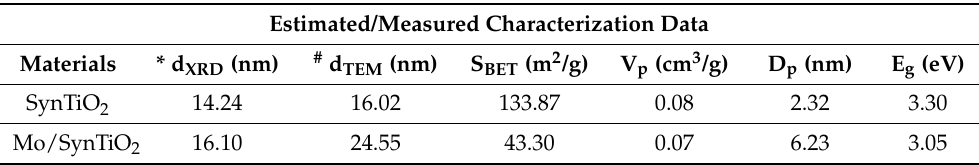
Table 1. Material properties of unmodified SynTiO 2 and modified Mo/SynTiO 2 material samples.